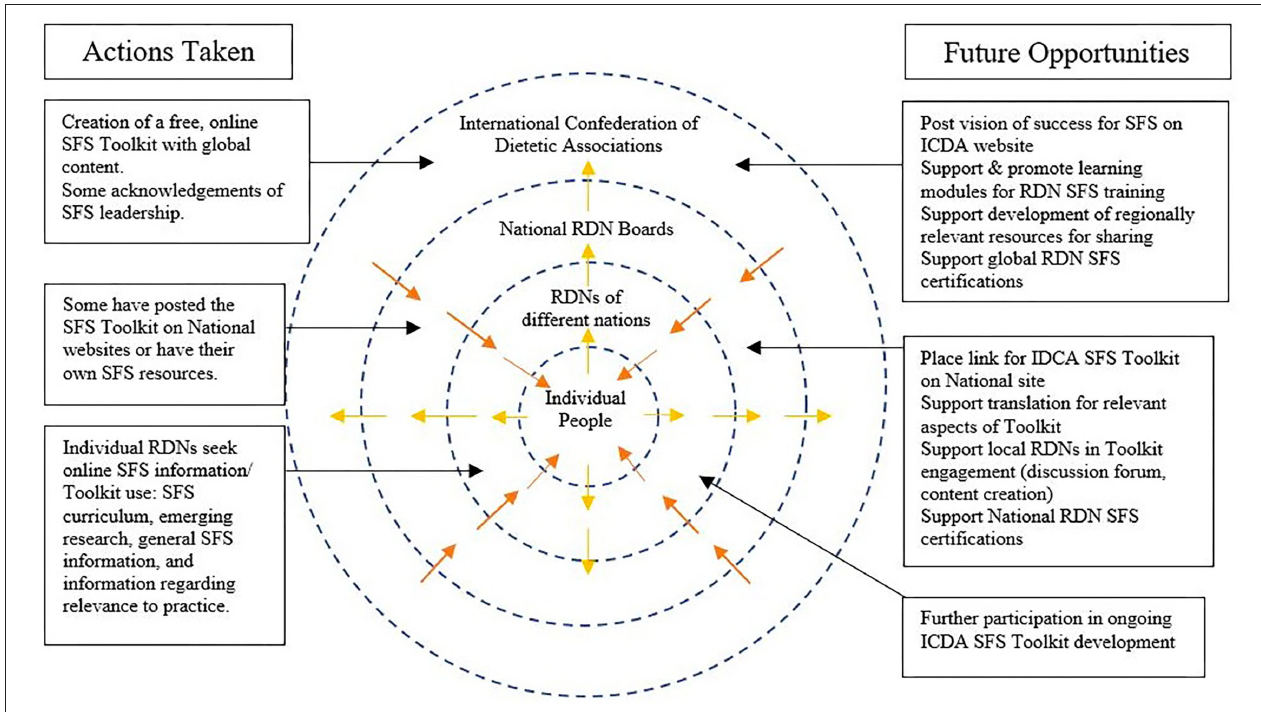
FIGURE 2 | Actions and opportunities across scales of the dietetics